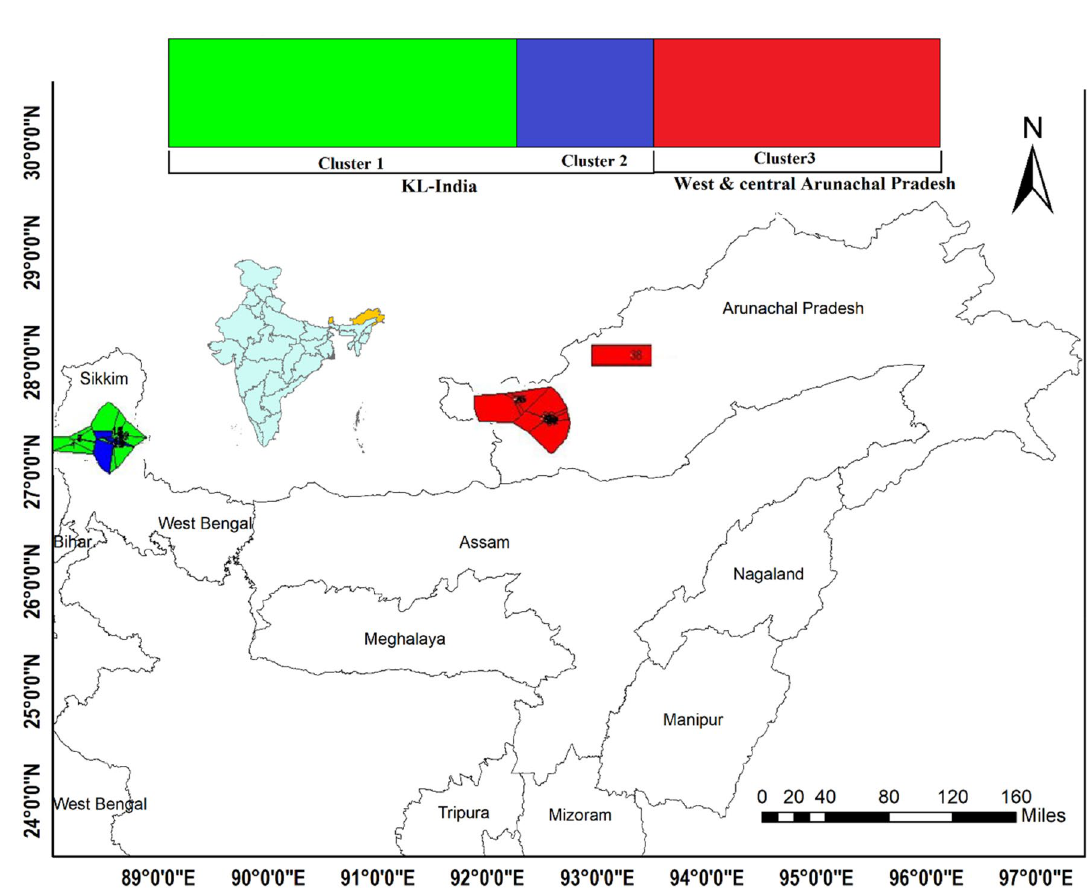
Figure 4. Bayesian analysis of population structure (BAPS) of A. fulgens interpreted three population cluster. Cluster 1 and 2 in green and blue colour representing KL-India population and cluster 3 in red colour representing west and central Arunachal Pradesh population of HRP. The Voronoi polygons on the map also represented the population clusters. (Map generated using ArcGIS: https ://www.arcgi s.com/index